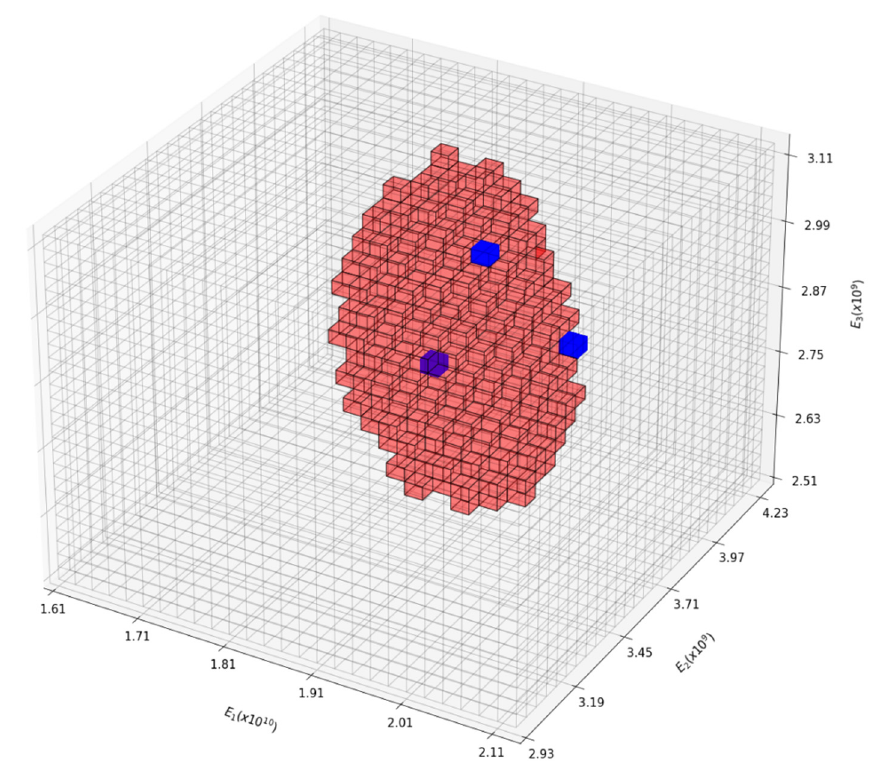
Figure 10. Sectorization 2 (3D). Number of control points: 3. E 1 , E2, and E 3 are the moduli of elasticity of concrete and foundation, riverbed, and abutments, respectively (Pa). The SD is a 3D volume obtained when applying a grid search algorithm (red in the figure). Blue cubes correspond to the 6 × 6 × 6 exploration net (EN) and are inside the SD The points or cubes that approximate the SD boundary were obtained from the three EPs inside the SD and the adjacent EPs by parabolic interpolation, following an analogous procedure as in the case of sectorization 1. Eighteen points (green cubes) were obtained this way. The lighter colored ones are at the front of the SD and the darker ones are at the back. The centroid of the SD was obtained from these eighteen points (black cube) (Figure 11).